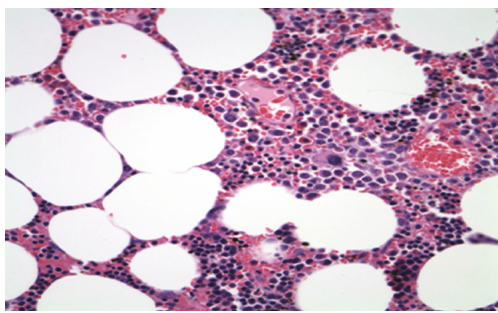
Figure 4: Intraoperative photo of intra-abdominal myelolipoma. Lesion is delineated by yellow ruler.